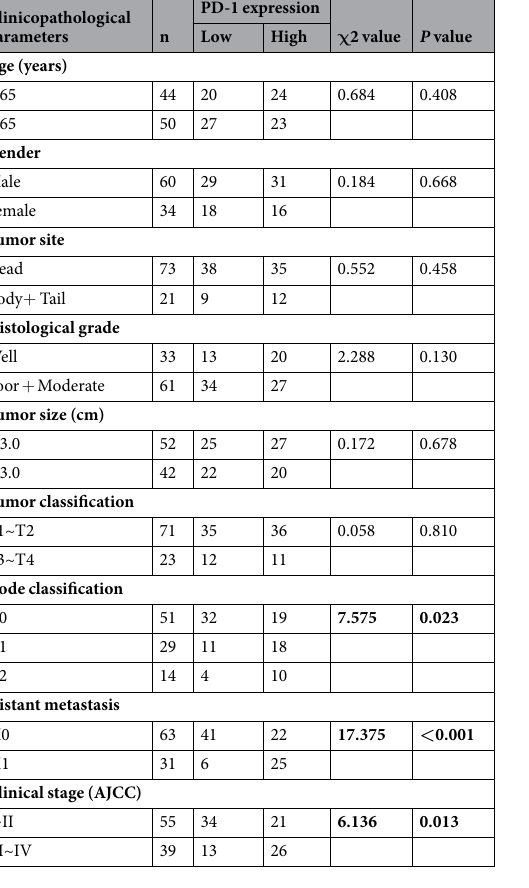
Table 1. Correlation of PD-1 expression on tumour-infiltrating CD8 + T cells with major clinicopathological parameters in patients with pancreatic ductal adenocarcinoma (PDAC). The bold numbers represent significant differences with P <